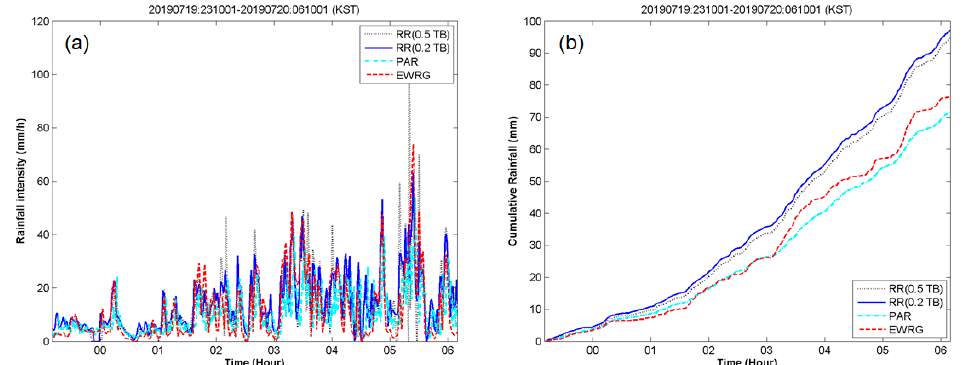
Figure 13. Comparison between rainfall obtained by the EWRG and rain gauges for event 3. ( a ) EWRG average rainfall (mm / h) and rain gauge rainfall (mm / h); ( b ) cumulative EWRG average rainfall (mm) and cumulative rain gauge rainfall (mm). The red dotted line represents the average rainfall of the EWRG prototype; the solid blue line and the black dotted line represent rainfall observed by the tipping bucket rain gauges (0.2, 0.5), and the light blue dashed line represents rainfall from the Parsivel disdrometer.